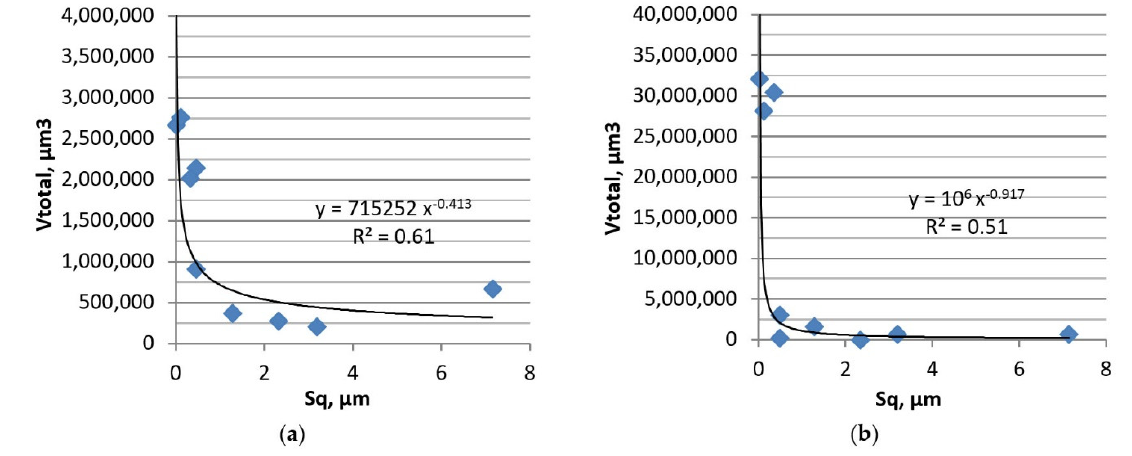
Figure 18. Dependence between the surface height of the disc and the total volumetric wear of the tribological system in tests B ( a ) and B1 ( b ).